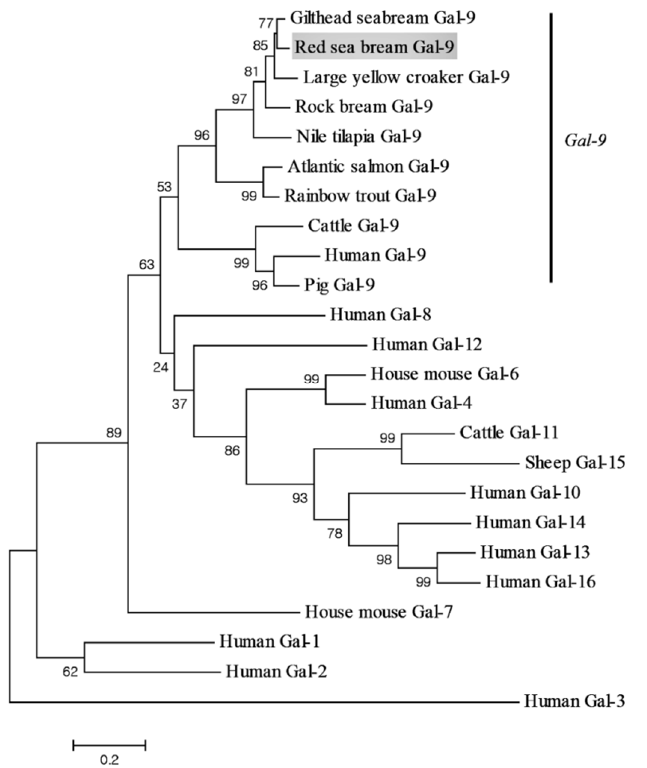
Figure 2. A phylogenetic tree of PmGal-9 and other known Gal-9 homologs based on the neighbor- joining (NJ) method. The scale bar indicates a branch length of 0.2. Numbers are bootstrap percentiles from 1000 replicates. This analysis is based on the following sequence data: Human Gal-1 (NP_002296), Human Gal-2 (NP_006489), Human Gal-3 (BAA22164), Human Gal-4